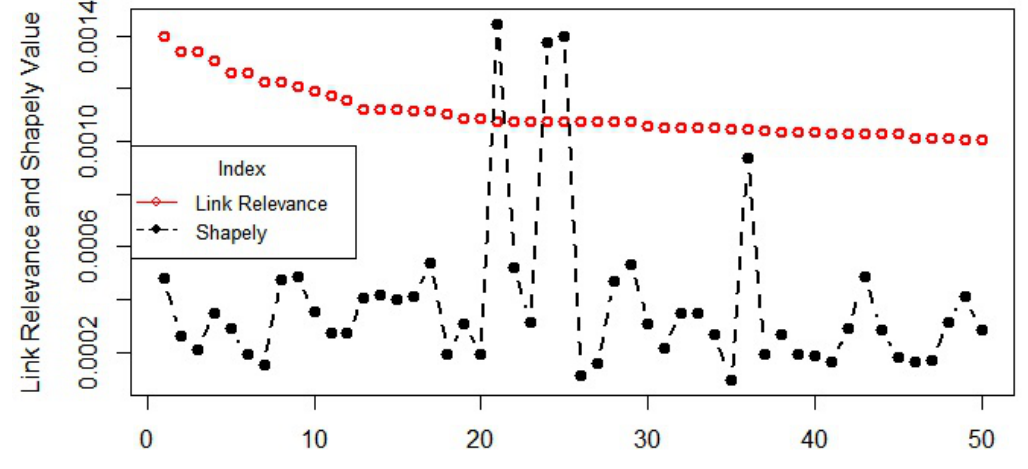
Figure 3. The relationship between the LRI and its corresponding Shapely value of the genes. The LRI (red hollow circle) of the top 50 genes and corresponding Shapely value (black solid circle) are plotted to analyze any similarity between